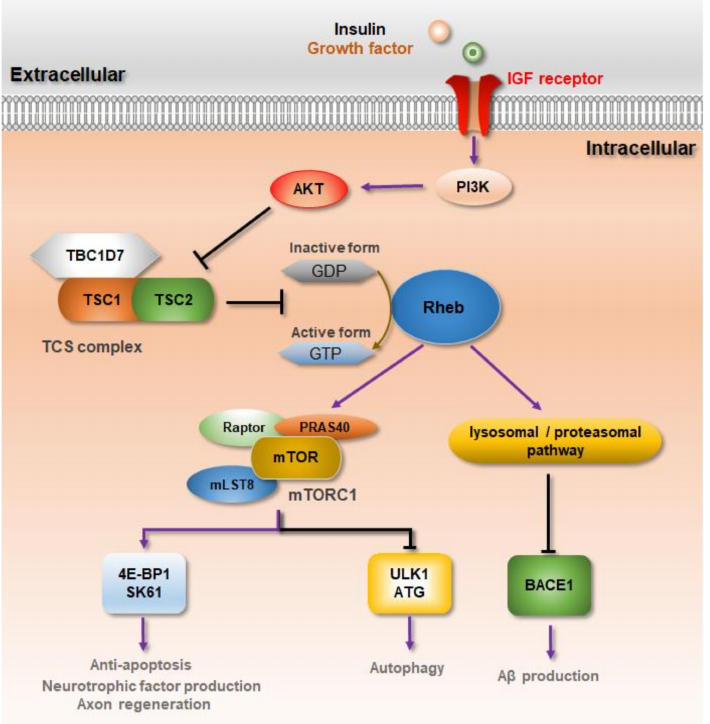
Figure 1. Rheb-mTORC1 signaling pathway in neurodegeneration. Binding of growth factors, such as insulin or insulin-like growth factor (IGF), to receptors stimulates PI3K signaling. The activity of PI3K-AKT mediates the activation of Rheb-mTORC1 by disinhibiting the Rheb-inhibiting TCS complex. Fully activated Rheb-mTORC1 phosphorylates S6K-1 or 4E-BP1 activate the protein of the translation machinery. In neurodegenerative diseases, Rheb-mTORC1 has negative effects, such as inhibition of autophagy, but promotes cell growth, regeneration, and neuroprotection by regulating the expression of neurotrophic factors, exon regeneration, and anti-apoptosis. In addition, Rheb inhibits A β formation through the induction of lysosomal and proteasomal degradation by binding to beta-secretase 1 (BACE) in Alzheimer’s disease (AD)